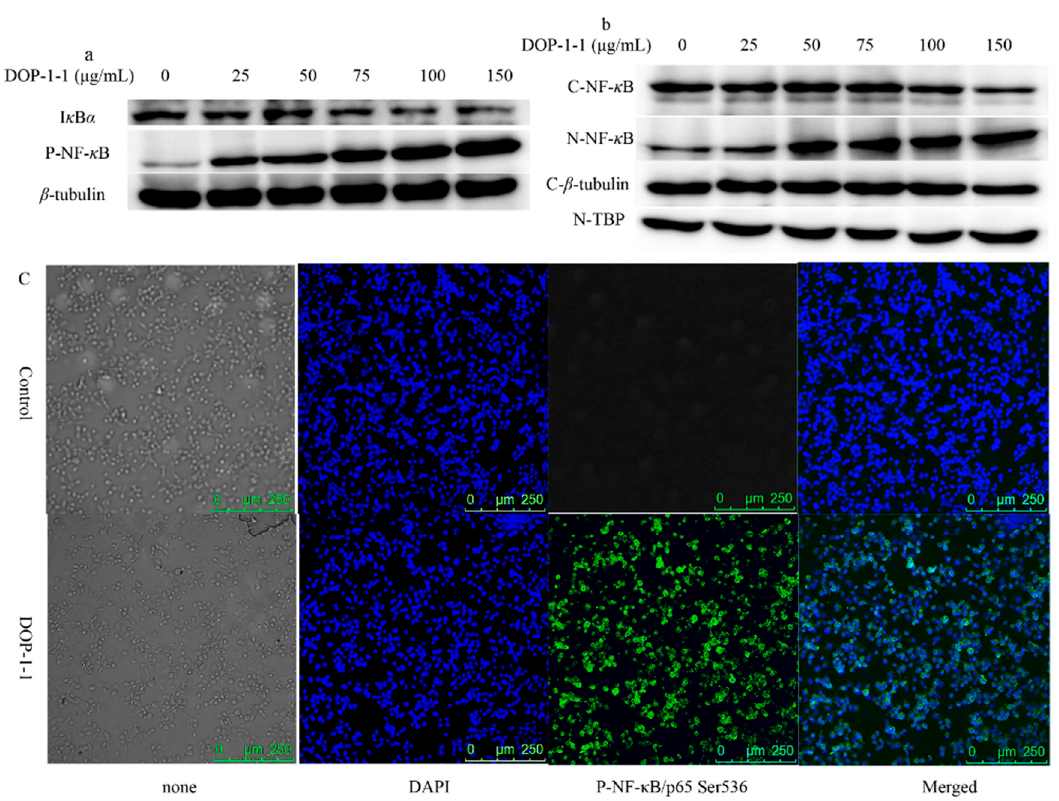
Figure 4. DOP-1-1 mediated immune response via NF- κ B. ( a ) Western blot of phosphorylated NF- κ B and I κ B α from whole proteins. ( b ) Western blot for cytoplasmic and nuclear fraction: C-NF- κ B and N-NF- κ B represent NF- κ B proteins in cytoplasm and nucleus, respectively; C- β -tubulin and N-TBP (TATA binding protein) were the internal reference for cytoplasm and nucleus, respectively. ( c ) Immunofluorescence of phosphorylated NF- κ B.